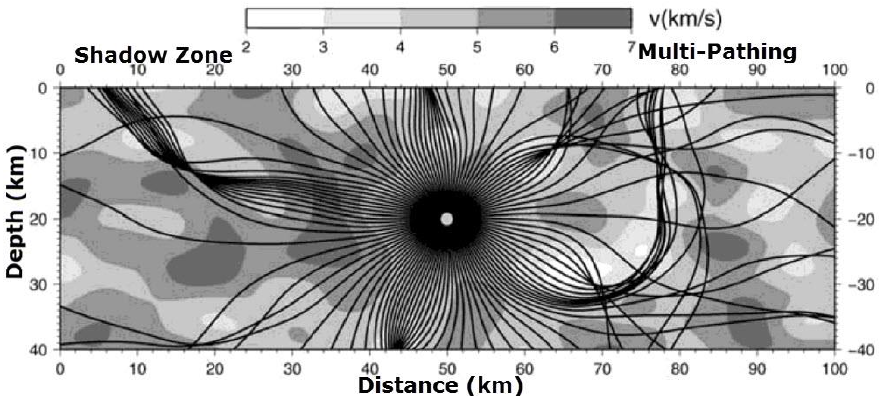
Figure 10. Trajectories of 100 rays emitted by a source point in a heterogeneous medium. Shadow zone and multipathing effects can be seen [30].